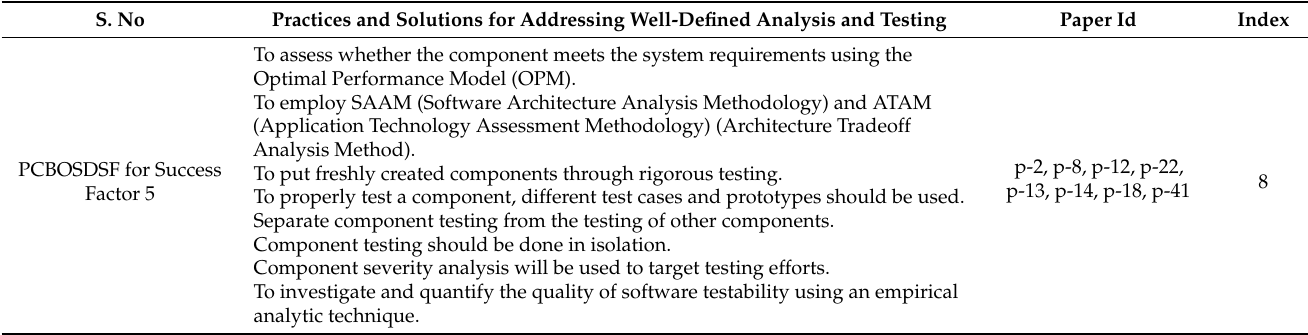
Table 9. CBOSDSF 5: Well-defined analysis and testing.